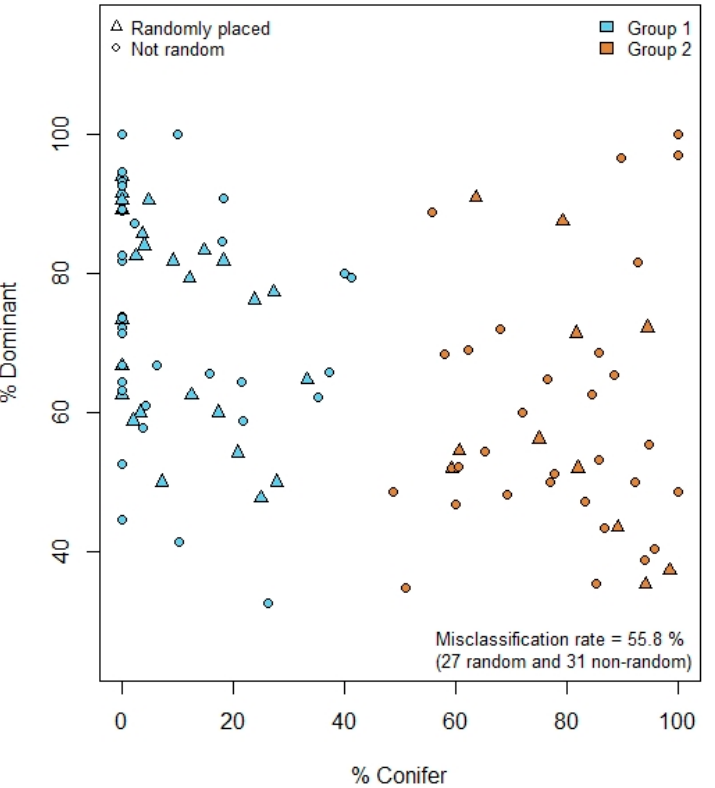
Figure A1. Results of k-means clustering on plot-level variables ( n = 104). Plots were sorted into two stable clusters over 50 iterations. The k-means-generated clusters did not correspond to whether the plot location was random or not. If there had been an effect, most triangles in the plot above would have been blue and most circles would have been orange (or vice versa). The misclassification rate was extremely high, with the majority of the random plots misclassified.